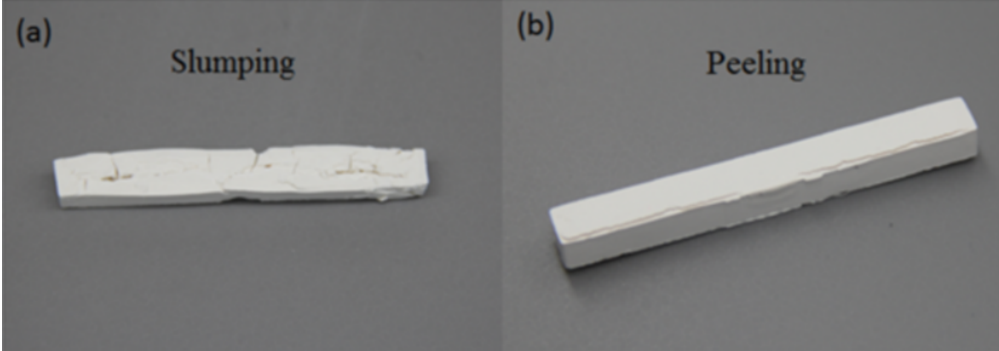
Fig. 5 The defects appeared in the solvent debinding: (a) “slumping” in the part with EVA (E); (b) “peeling” in the part with EVA/HDPE